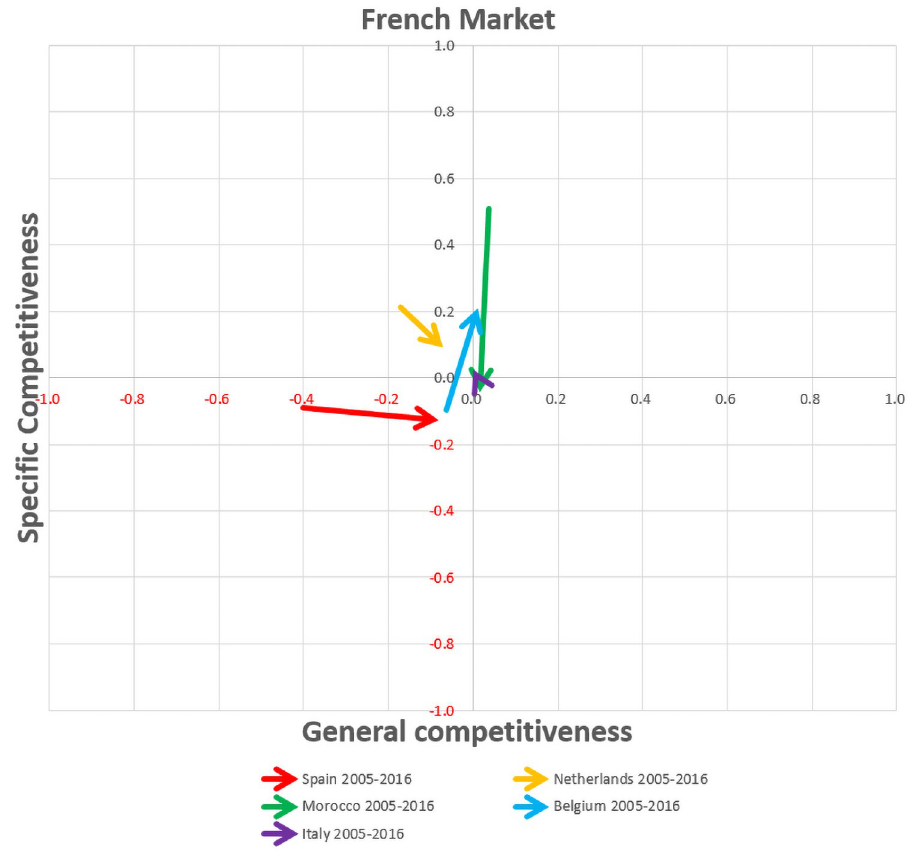
Fig 17. Competitiveness map for competing countries group in the French